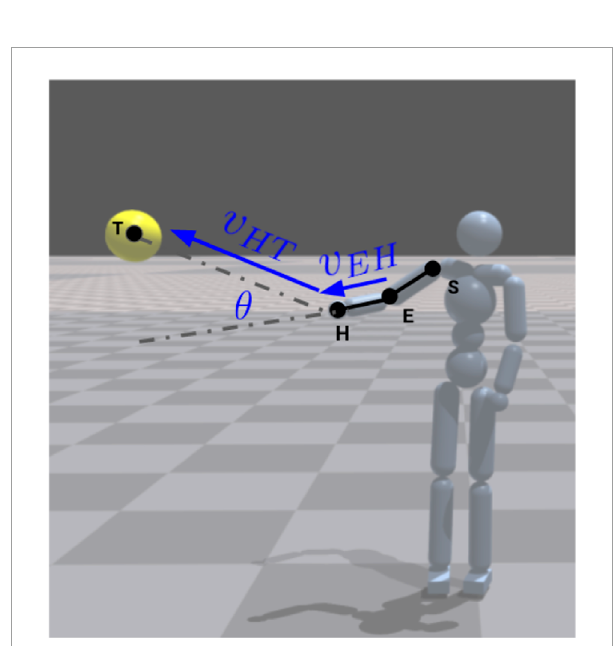
FIGURE 5 Pointing reward based on angle between vector from elbow joint (E) to hand joint (H) and vector from hand joint to target position (T). Agent rendered in the IssacGym physics engine Makoviychuk et al.